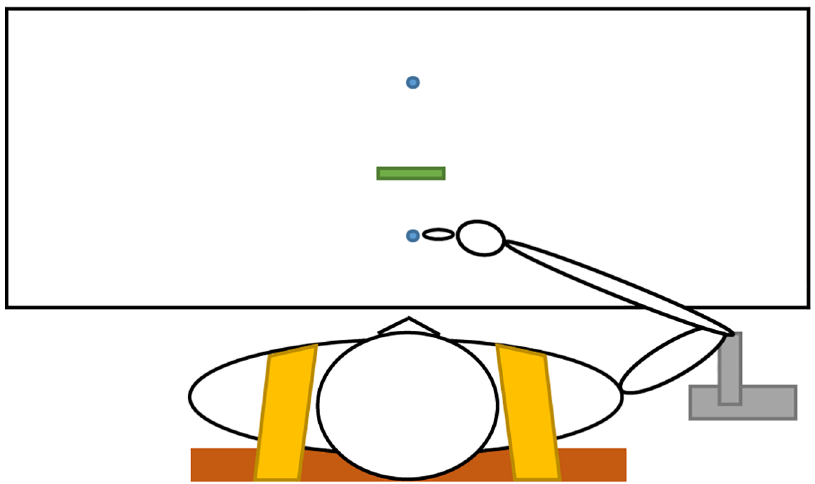
Fig 1. Bird’s-eye view of the set-up of the experiment where the participant is in starting position. The elbowof the participant is on the grey stand and the fingertip of the participantis on the start target. The second blue dot is the end target and the green rectangle is the obstacle. The participantis strappedto the brown chair with the yellow